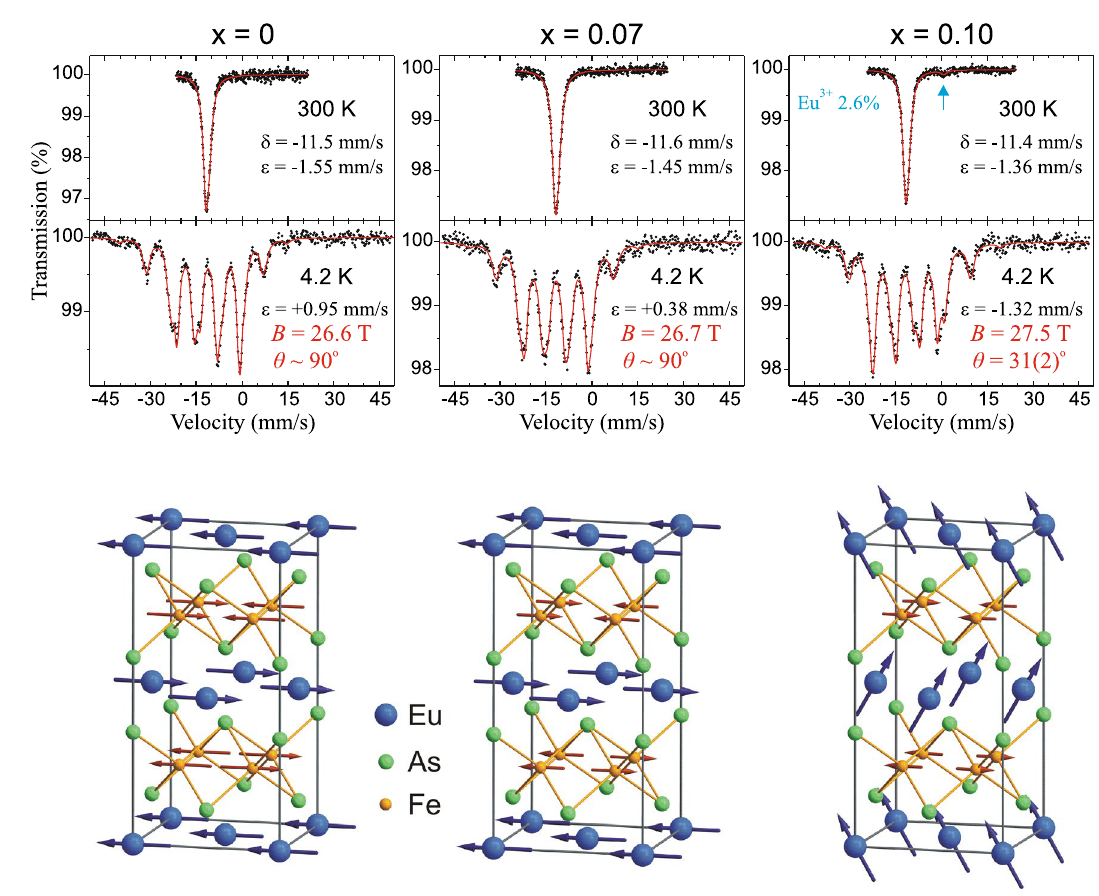
Figure 10. The 151 Eu Mössbauer spectra of EuFe 2−x Ni x As 2 with x = 0, 0.07, 0.10. The hyperfine magnetic field for Eu 2+ is denoted by B , while the symbol θ stands for the angle between the principal component of the EFG ( c -axis of the unit cell) and the Eu 2+ hyperfine field (4 f -Eu magnetic moment). The symbols δ and ε stand for the spectral center shift relative to room temperature 151 SmF 3 source and the quadrupole shift, respectively. The arrow on spectrum of x = 0.10 at 300 K shows position of the Eu 3+ component with ε = +0.8(2) mm/s and Γ a = 1.6(6) mm/s. (Lower panel) Sketches of the corresponding magnetic structures of EuFe 2−x Ni x As 2 system at the ground state emerging from the 57 Fe and 151 Eu Mössbauer results at 4.2 K. The gray line outlines the orthorhombic unit